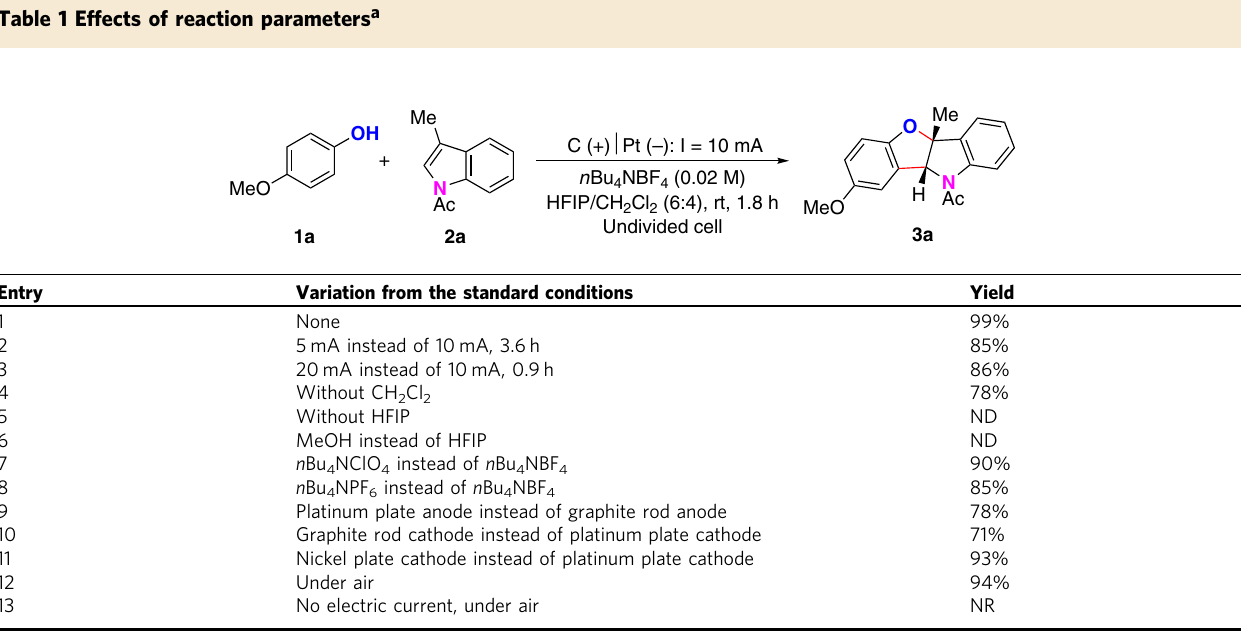
Table 1 Effects of reaction parameters